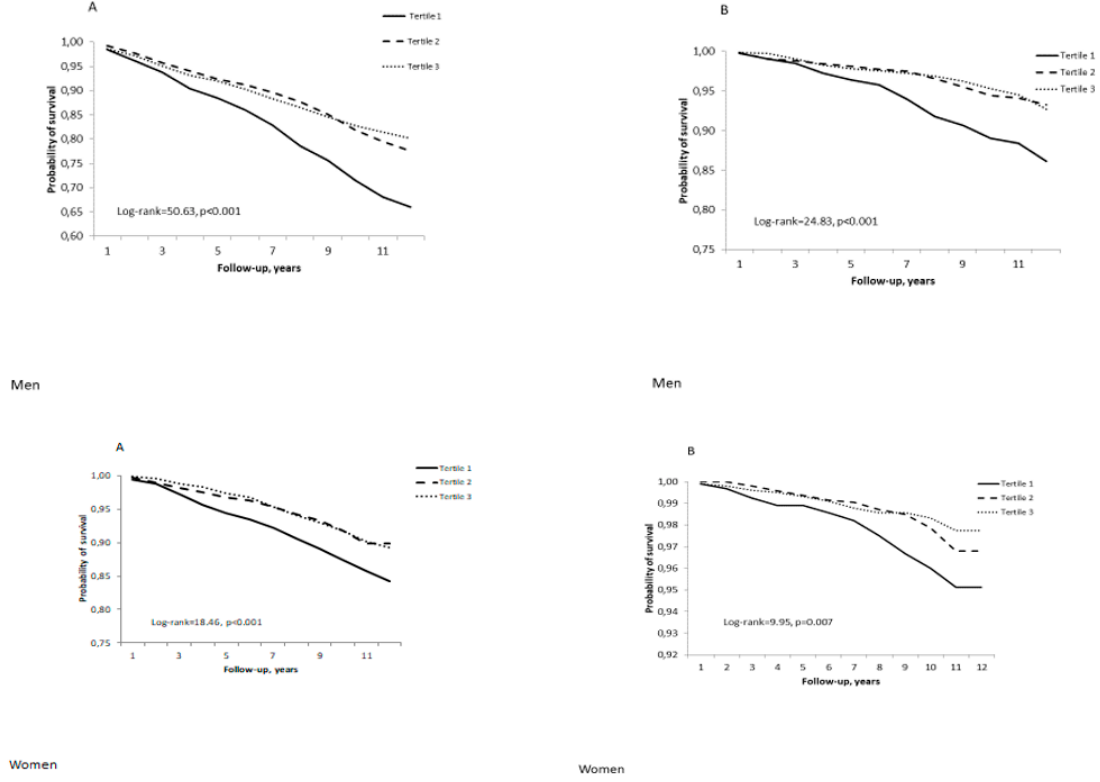
Figure 1. Kaplan-Meier survival (all-cause ( A ) and cardiovascular ( B ) mortality) curves according to the tertiles of a composite score of cognitive function for men and women.